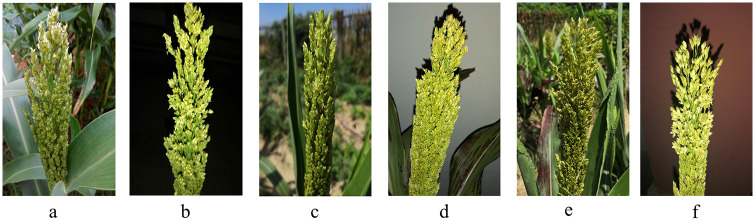
The opening state of sorghum florets after exogenous methyjasmonate treatments.a-0h after the treatment of 0.0 mmol/L, b-6.5h after the treatment of 0.0 mmol/L, c-0h after the treatment of 0.5 mmol/L, d-4.5h after the treatment of 0.5 mmol/L, e-0h after the treatment of 2.0 mmol/L, f-2.5h after the treatment of 2.0 mmol/L.